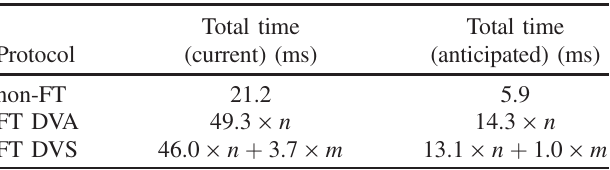
TABLE VII. Time required for one cycle of error correction with both current and future hardware, assuming the shuttling- based, two-species protocol. Parameter n is the number of rounds of error correction applied (usually n ¼ 2 , but n ¼ 3 when the initial two rounds disagree). Parameter m is the number of additional attempts at preparing the GHZ ancilla state beyond the minimum because of detection of error(s) when verifying the ancilla. On average, m ¼ 0 . 66 for current hardware and m ¼ 0 . 02 for future